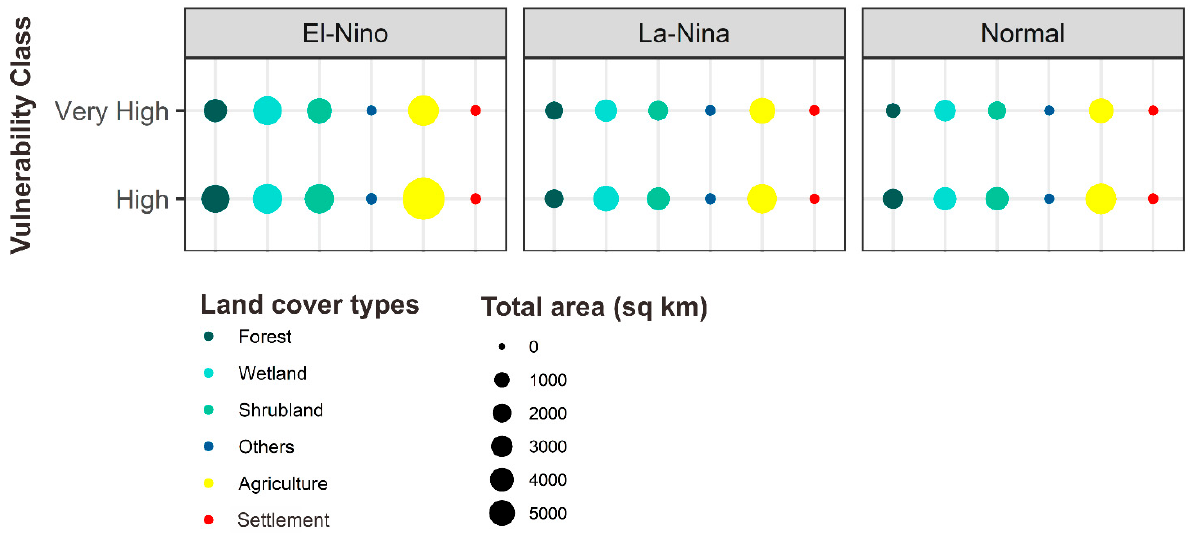
Figure 7. High and very-high peatland vulnerability to fires under ENSO phases within different land cover types. The size of dots indicates total area of vulnerability classes in squared km.